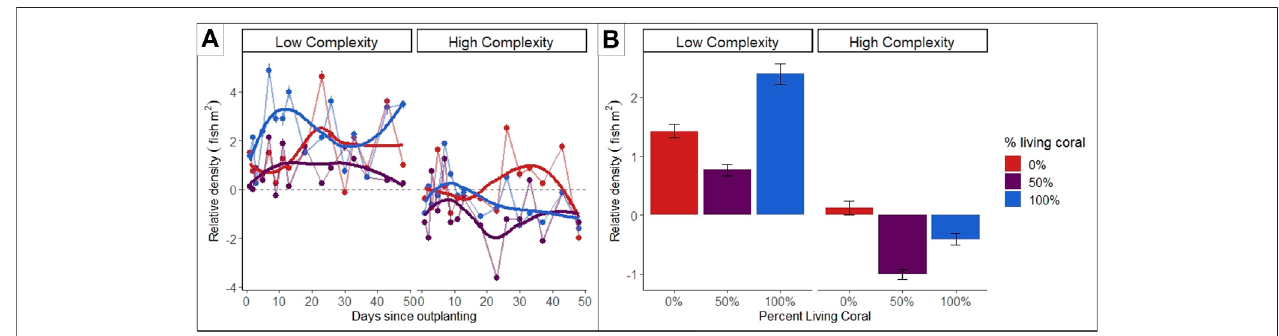
FIGURE5|(A) Mean fi shrecruit( $ 3 cm)densityforeachsubstratecompositiontreatment(mean±S.E)withlocalpolynomialregressionoverlayoverthelengthof the experiment since corals were added to the benthos via “ outplanting ” (Days 1 – 50). (B) Mean fi sh recruit density (± S.E.) of fi sh recruits ( $ 3 cm) associated with the habitat patches in three treatments of % living coral (i.e., ratio of arti fi cial coral to live coral modules, n treatment = 12): 0% = 0 living coral/10 arti fi cial coral, 50% = 5 living coral/5arti fi cialcoral,l,100%=10livingcoral/0arti fi cialcoral,control=0livingcoral/0arti fi cialcoral.Densitywasstandardizedtoambientrecruitdensitymeasured at control patches within Low and High complexity sites,